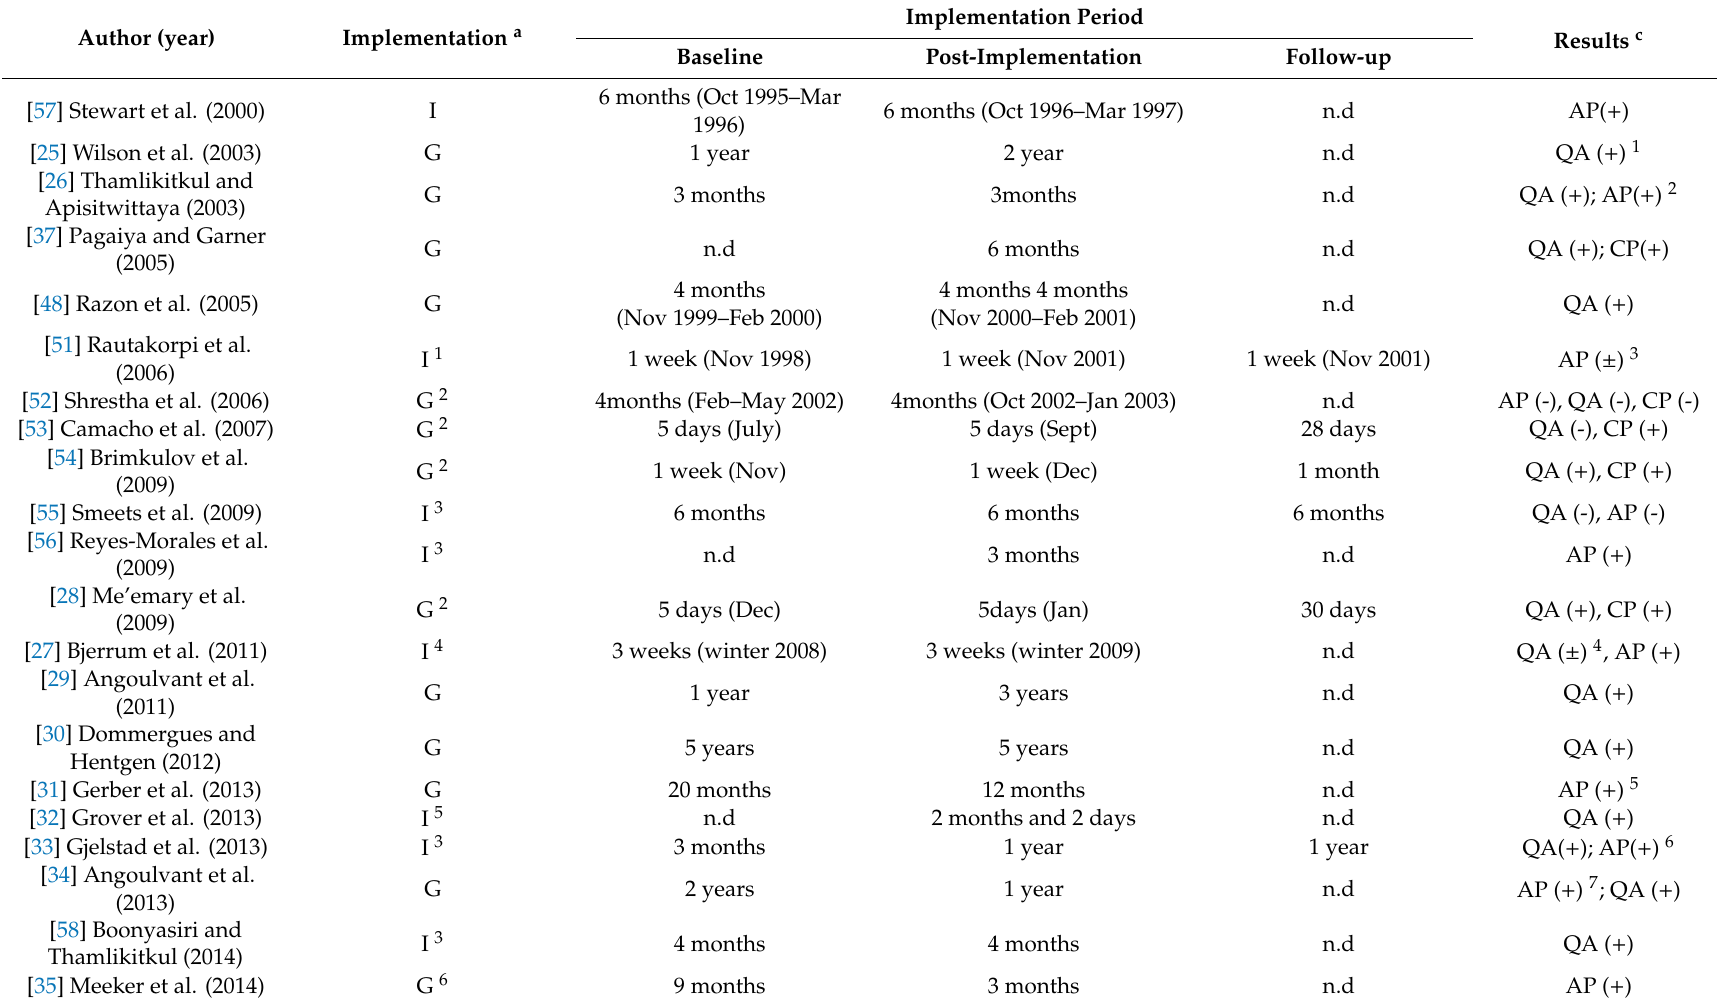
Table 2. Summary of interventions of the included